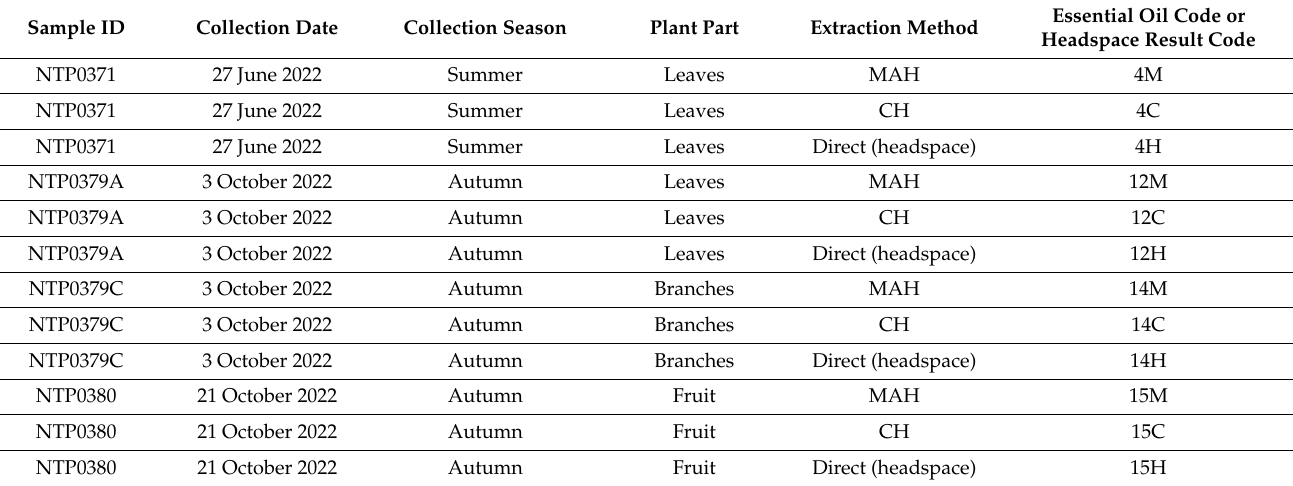
Table 1. Myrica gale collections, extraction methods and corresponding codes for results; MAH—microwave- assisted hydrodistillation; CH—Clevenger